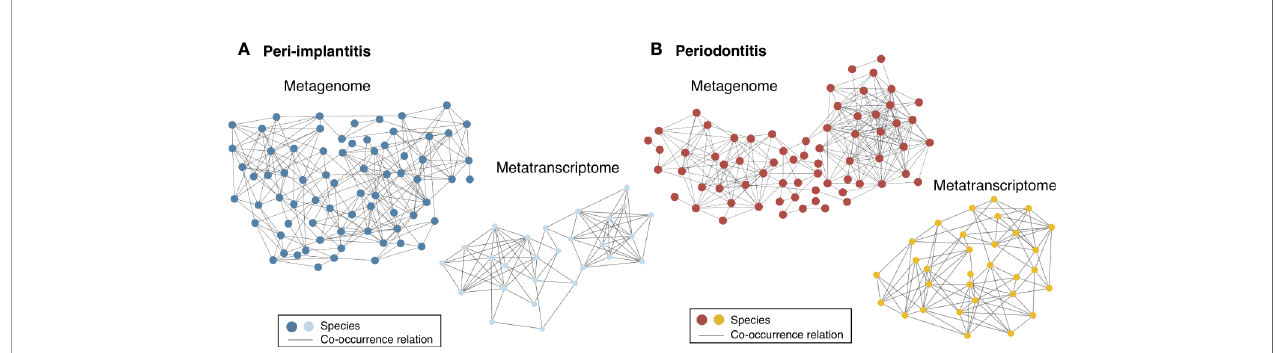
FIGURE 2 | Comparison of co-occurrence networks of taxonomic pro fi les between metagenome and metatranscriptome. Species which were present in more than 50% of individuals in each group were used for co-occurrence network analysis. All networks are shown with each species and co-occurrence relationship indicated by a node and an edge, respectively. (A) Co-occurrence network pro fi le-based taxonomic pro fi le derived from functional genes among peri-implantitis samples comparing metagenome (blue circles) and metatranscriptome (light blue circles) results and (B) among periodontitis samples comparing metagenome (red circles) and metatranscriptome results (light red circles).